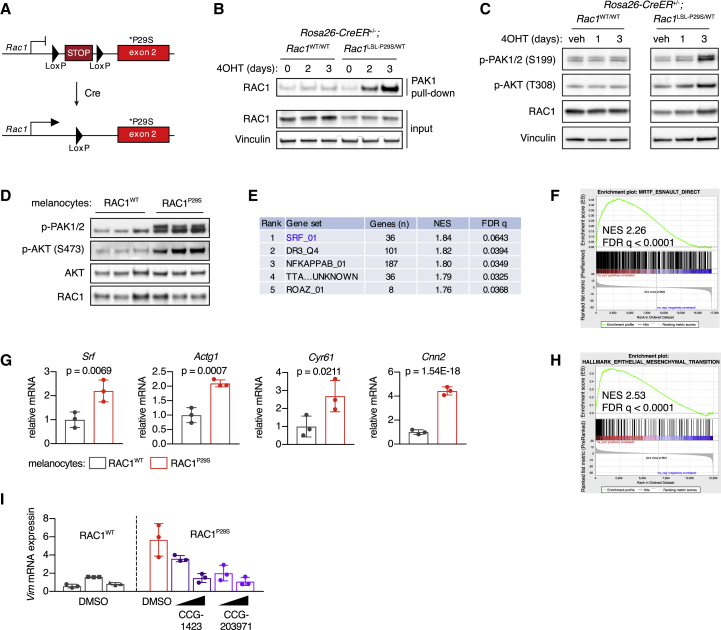
Impact of Endogenous RAC1P29S on AKT and SRF/MRTF Activation in Melanocytes and Mesenchymal Phenotype(A) Schematic of the Rac1LSL−P29S allele.(B) Rosa26-CreER+/–;Rac1LSL−P29S/WT and Rosa26-CreER+/–;Rac1WT/WT MEFs were isolated and recombined using 1 μM 4OHT. Activation of RAC1 was assessed using pull-down assay.(C) Phosphorylation of PAK1/2 and AKT in MEFs upon recombination of the Rac1LSL−P29S allele by 4OHT treatment (1 μM).(D) Phosphorylation of PAK1/2 and AKT in mouse melanocytes with endogenous RAC1P29S. Immunoblot of three independent cultures per genotype is shown.(E) Transcription factor target enrichment analysis of gene expression changes in melanocytes with endogenous RAC1P29S versus RAC1WT. GSEA was performed using the transcription factor target gene set collection from MSigDB in combination with RNA-seq data of melanocytes from Rac1LSL−P29S/WT mice versus Rac1WT/WT mice (n = 3 independent cultures per genotype).(F) GSEA results using SRF/MRTF/TCF gene sets from Esnault et al. (2014), was applied on RNA-seq data from melanocytes cultured with endogenous RAC1P29S versus RAC1WT. GSEA plot for direct targets of MRTF is shown.(G) Normalized mRNA read counts of canonical SRF/MRTF targets in melanocytes with endogenous RAC1P29S (n = 3 independent cultures per genotype); Wald test was applied in combination with Benjamini-Hochberg correction.(H) GSEA plot of the curated EMT hallmark gene set from MSigDB using RNA-seq data of melanocytes from Rac1LSL−P29S/WT mice versus Rac1WT/WT mice (n = 3 independent cultures per genotype).(I) Effect of SRF/MRTF pathway inhibition on mRNA expression of vimentin in mouse melanocytes with endogenous RAC1P29S. Cells were treated with 10–25 μM CCG-1423 or CCG-203971 and starved of TPA for 24 h (n = 3 independent experiments).For all graphs: bars represent means ± SD. See also Figure S3.